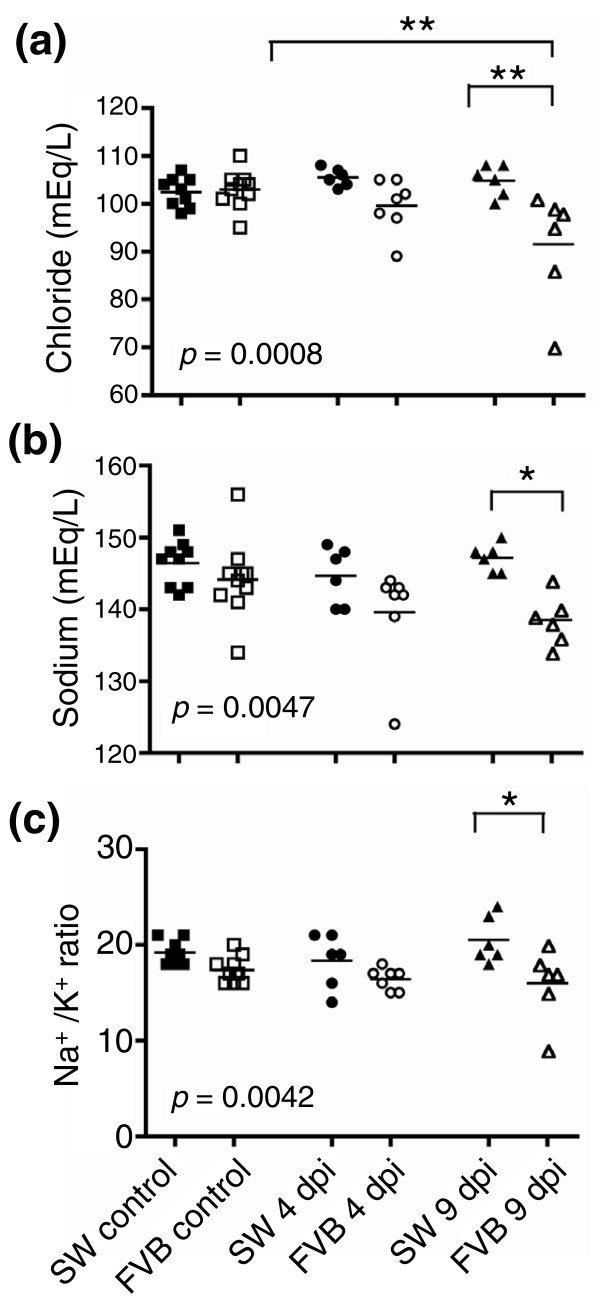
Serum electrolyte levels. Infected FVB mice had (a) hypochloremia, (b) hyponatremia, and (c) altered Na+/K+ ratio in serum compared with infected SW mice. Each symbol represents an individual mouse; lines indicate means of the group. *p < 0.05; **p < 0.01.